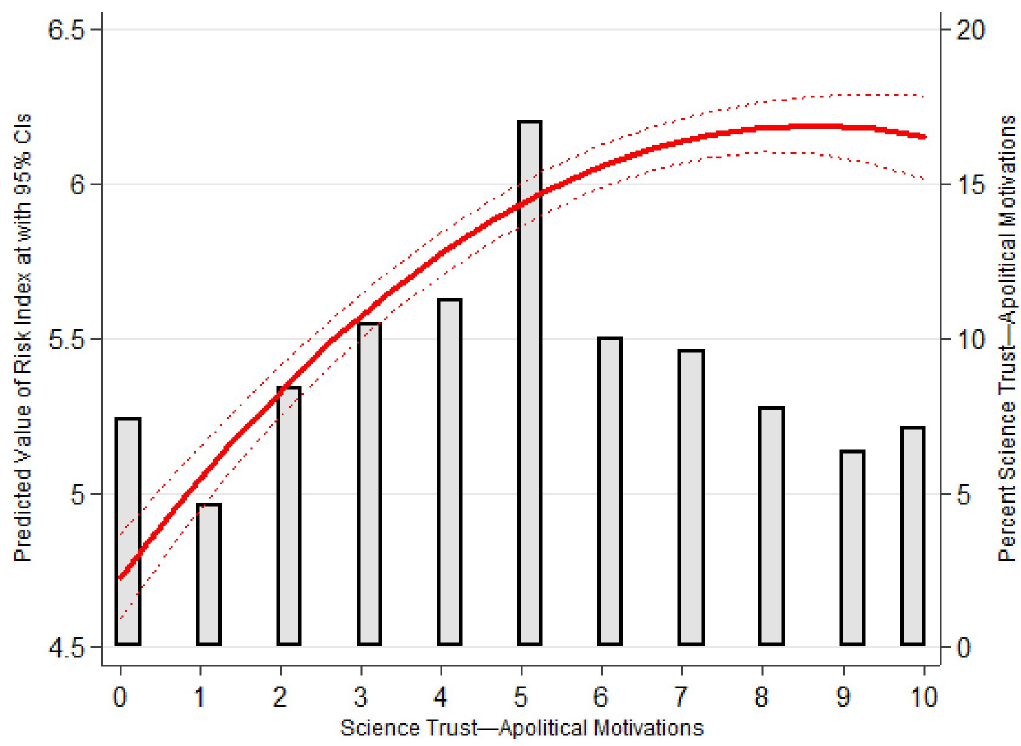
Fig 1. Predicted values of Risk Index across values of Science Trust—Apolitical Motivations with embedded histogram.